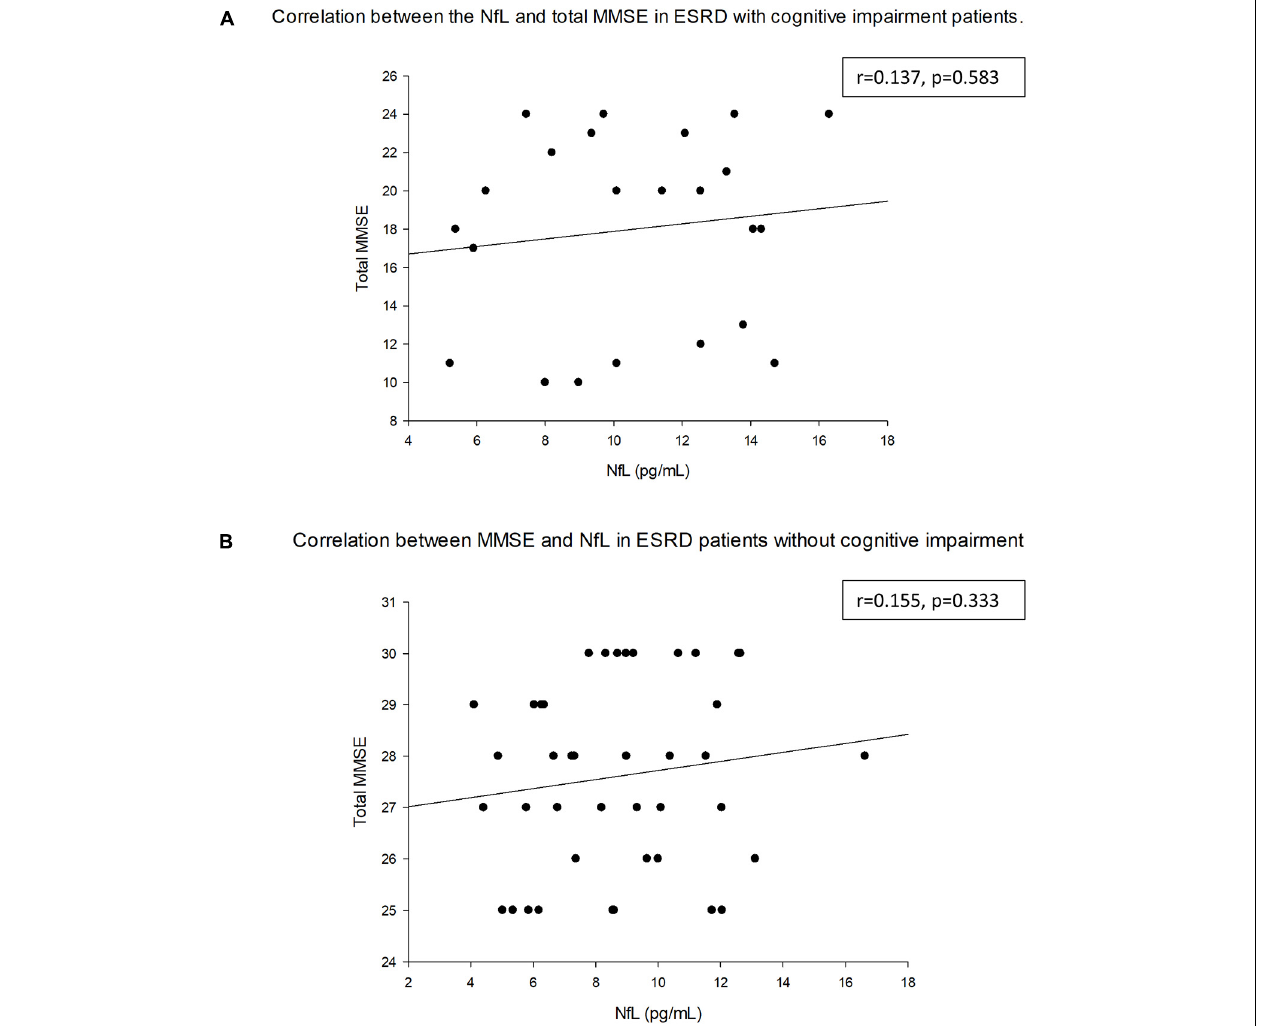
FIGURE 4 | Correlation between NfL and total MMSE with (A) and without (B) cognitive